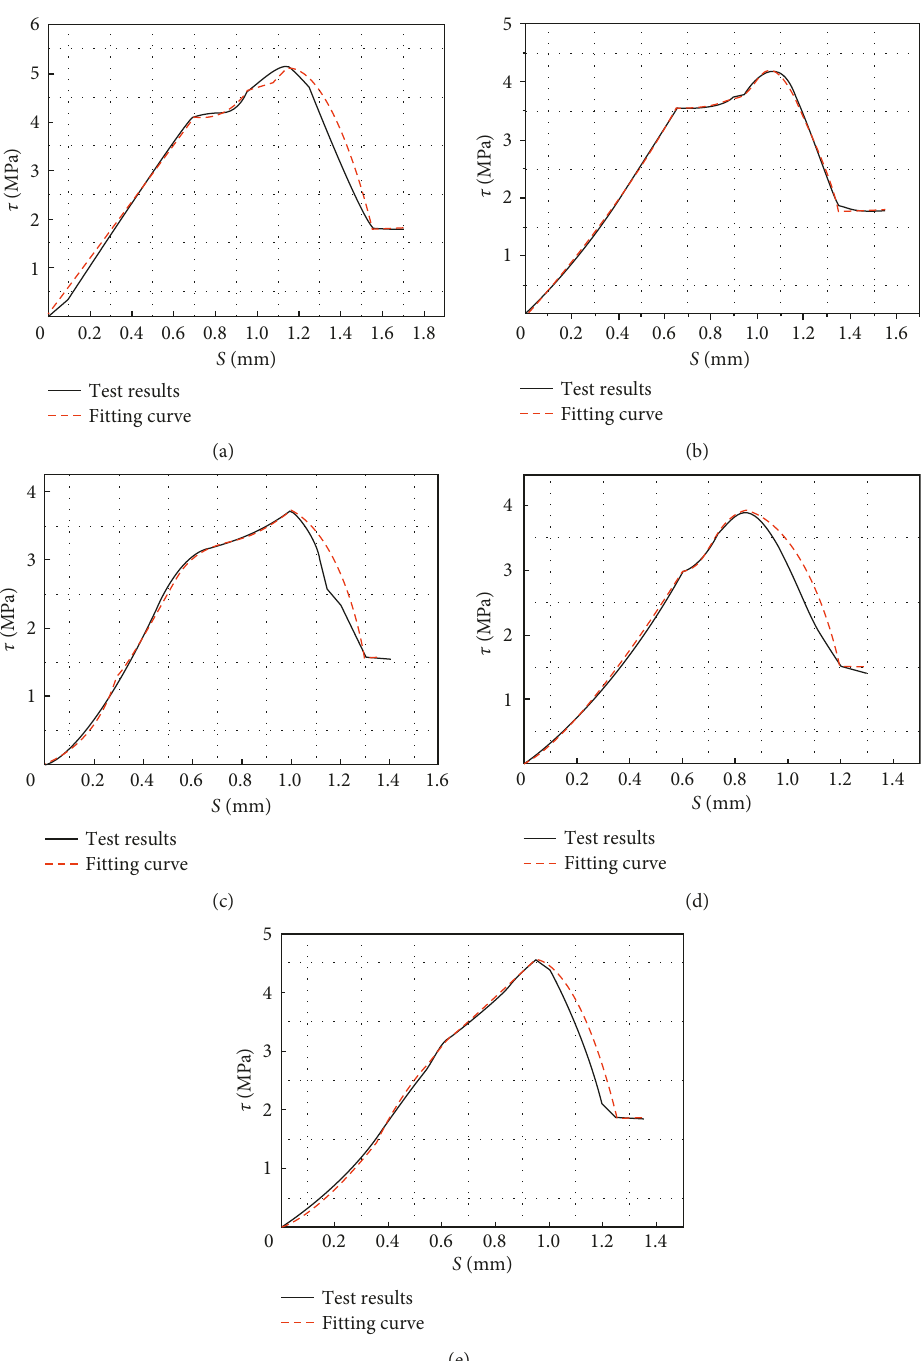
Figure 12: Comparison of experimental and fitting results of different specimens. (a) D90-L90. (b) D90-L135. (c) D90-L180. (d) D80-L120. (e)